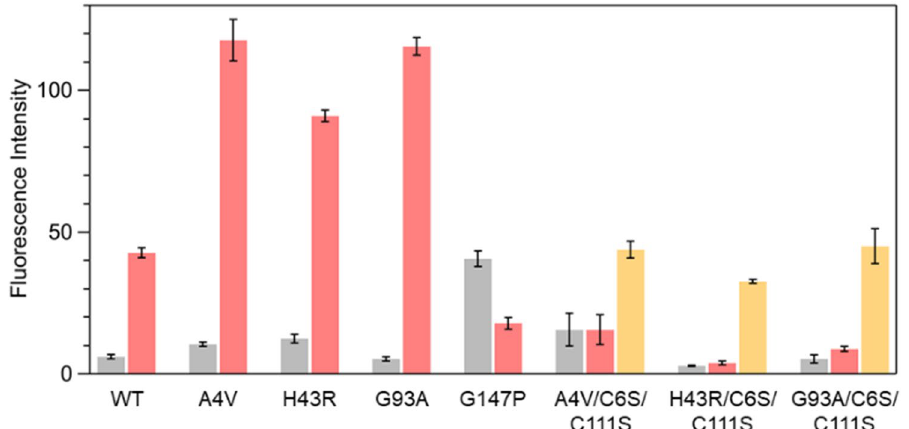
Figure 3. DCF fluorescence intensities of apo-WT, apo-A4V, apo-H43R, apo-G93A, apo-G147P, apo-A4V/ C6S/C111S, apo-H43R/C6S/C111S, and apo-G93A/C6S/C111S. Gray and red bars show the fluorescence intensities before and after the incubation, respectively. Orange bars show those after the incubation with 10 mM DTT. Detailed information on the incubation conditions is given in the Materials and Methods Section and in the text. Error bars are SE ( n =